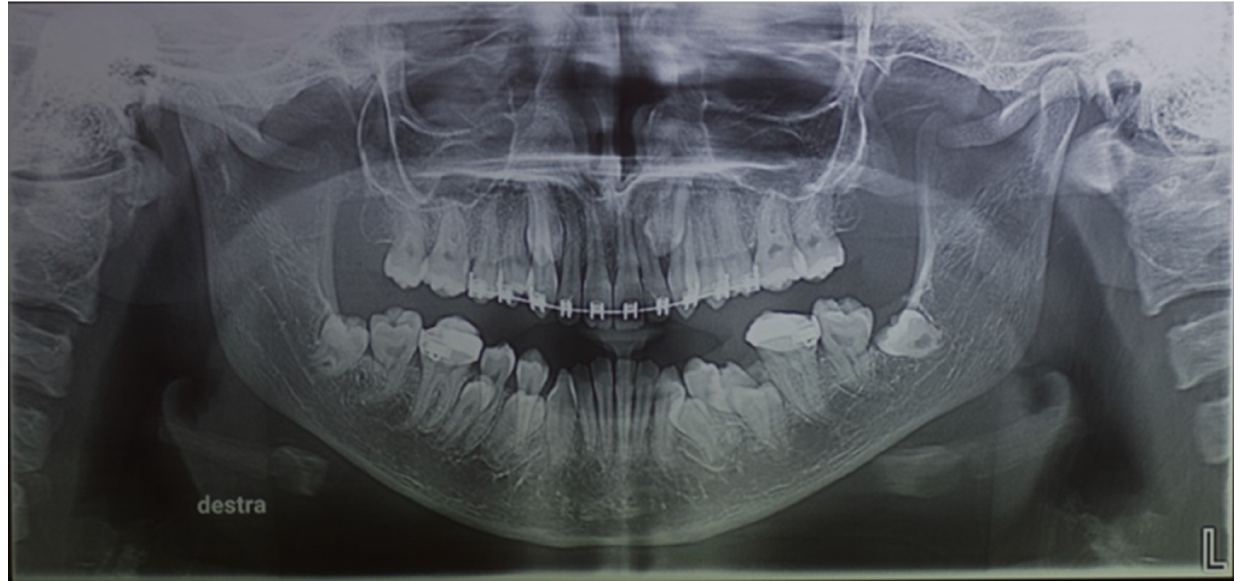
Figure 8. Orthopantomography (OPG) X-ray of a 21-year-old: dental laceration of 3.5, unerupted left and right lower third molar, absence of the upper third molars, and supernumerary teeth (two upper canines and four lower premolars). The impacted supernumerary teeth were immature with incomplete root development.